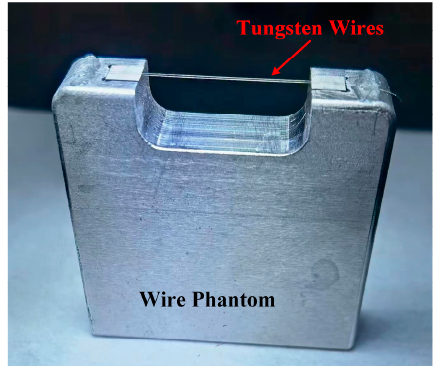
Figure 9. The tungsten wire phantom.